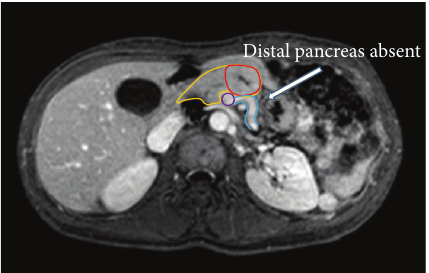
Figure3:Histopathologicaldescriptionofthetumor.Itiscomposed of multiple nests with hyalinized fibrovascular stroma. Tumor cells are relatively uniform with finely granular eosinophilic cytoplasm and centrally located round to oval nucleus with “salt and pepper” chromatin pattern. There were less than 2 mitoses per high-powered field. The tumor was chromogranin positive after immunohisto- chemical analysis (not